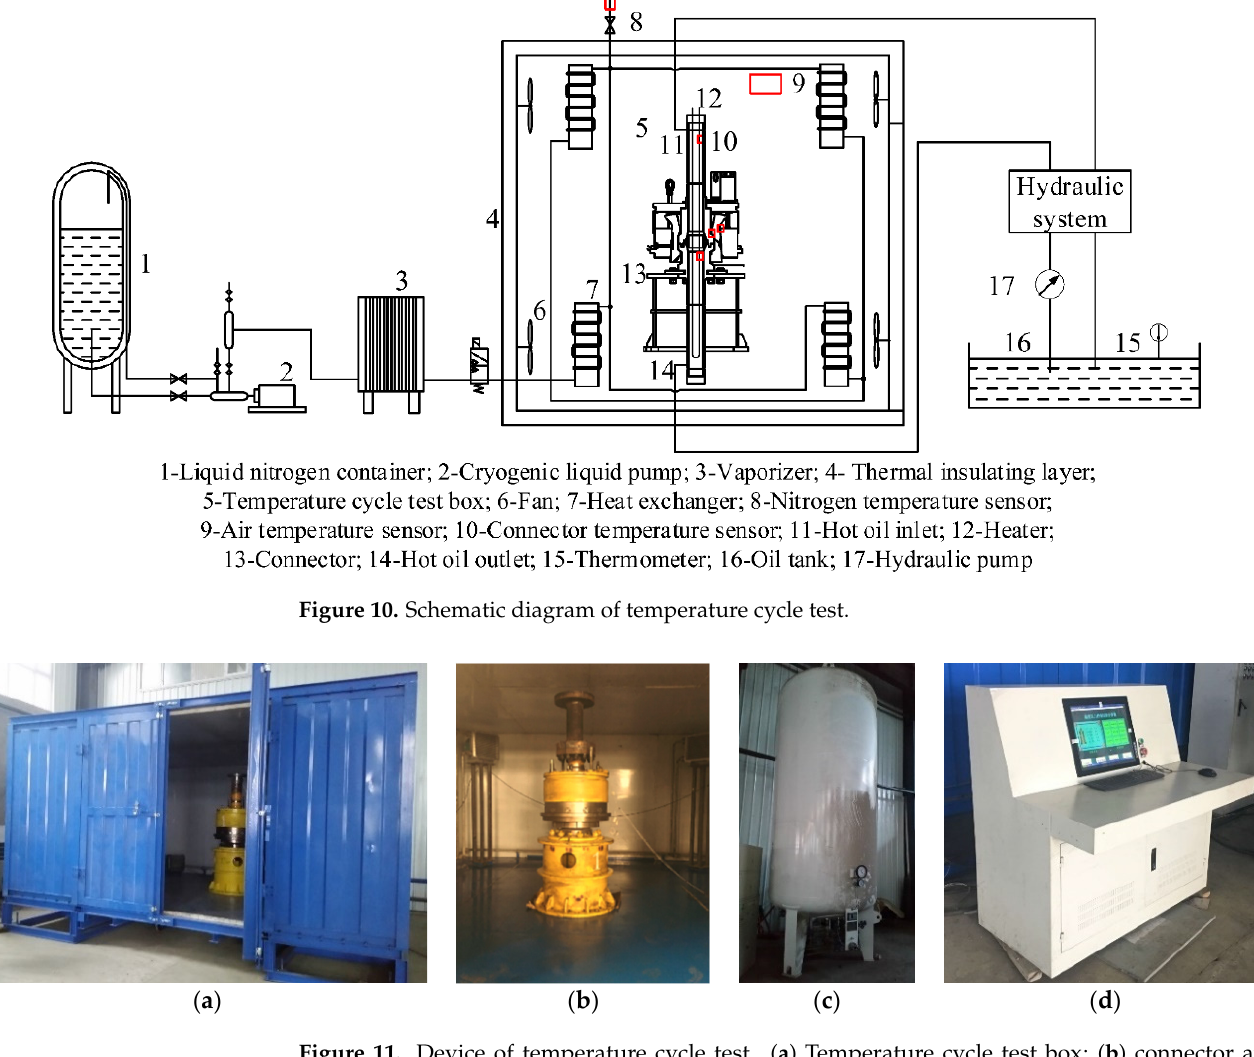
Figure 12. Flow chart of temperature cycle test loading. 5.2. Analysis of Temperature Data The holding-pressure data of the temperature cycle test is shown in Table 7. 1.